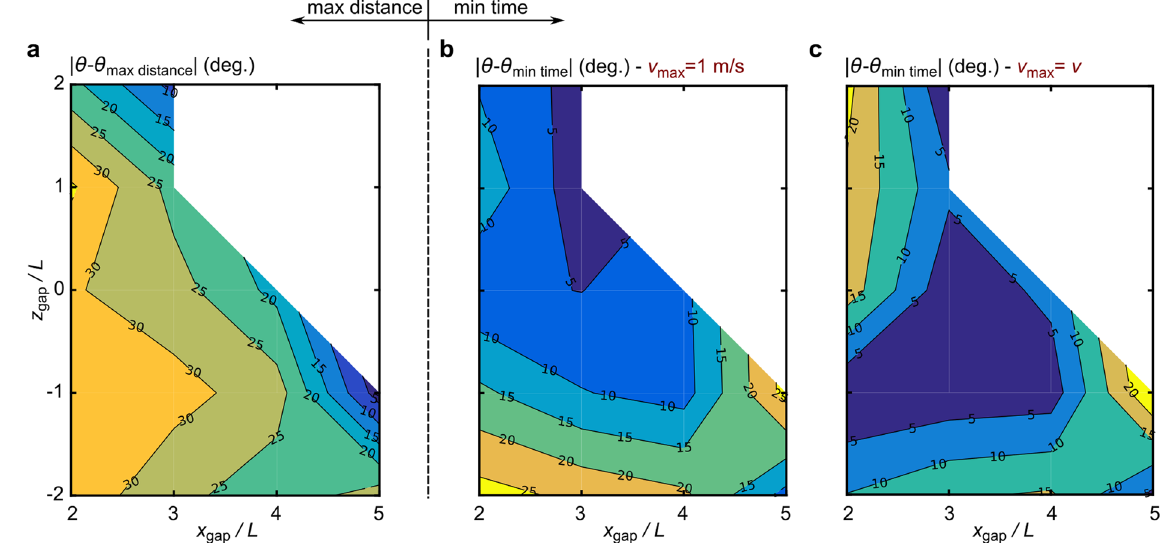
Figure 7. Contour plots for comparison of measured take-off angles for different jumping tasks with the theoretical take-off angles required for ( a ) minimum cost of transport and ( b , c ) minimum time of flight. Plots show the magnitude of the difference in angle for clarity of interpretation. In each case darker colours correspond to jumping at closer to the respective optimum conditions. In plot ( b ), minimum flight time angles are computed based on a reference take-off velocity of 1 m/s. In plot ( c ), minimum flight time angles are computed based on a reference take-off velocity equal to the take-off velocity of each